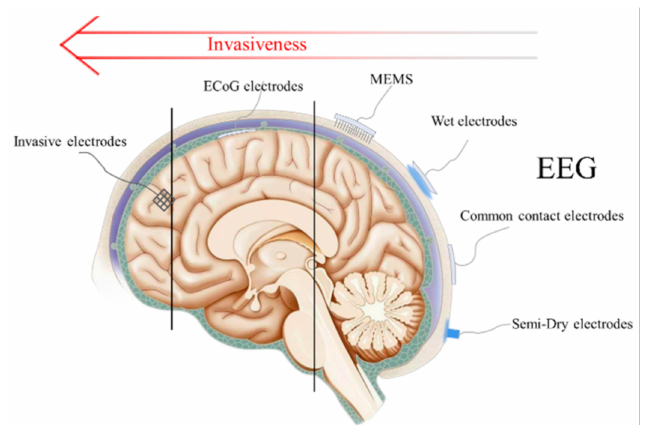
Figure 2. Schematic diagram and invasiveness degree of EEG electrodes, ECoG electrodes and invasive electrodes.